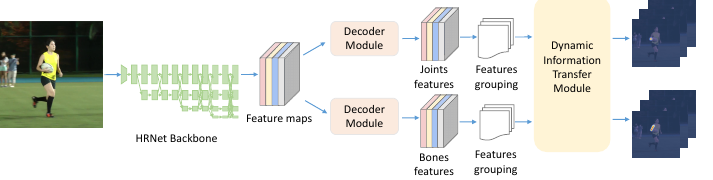
Figure 2. The proposed multi-task learning framework. The network employs a convolutional network with shared parameters to extract joint and bone features for each person. By performing feature grouping, the corresponding joint and bone features are sent to the dynamic information transfer module (DITM) to achieve refined pose